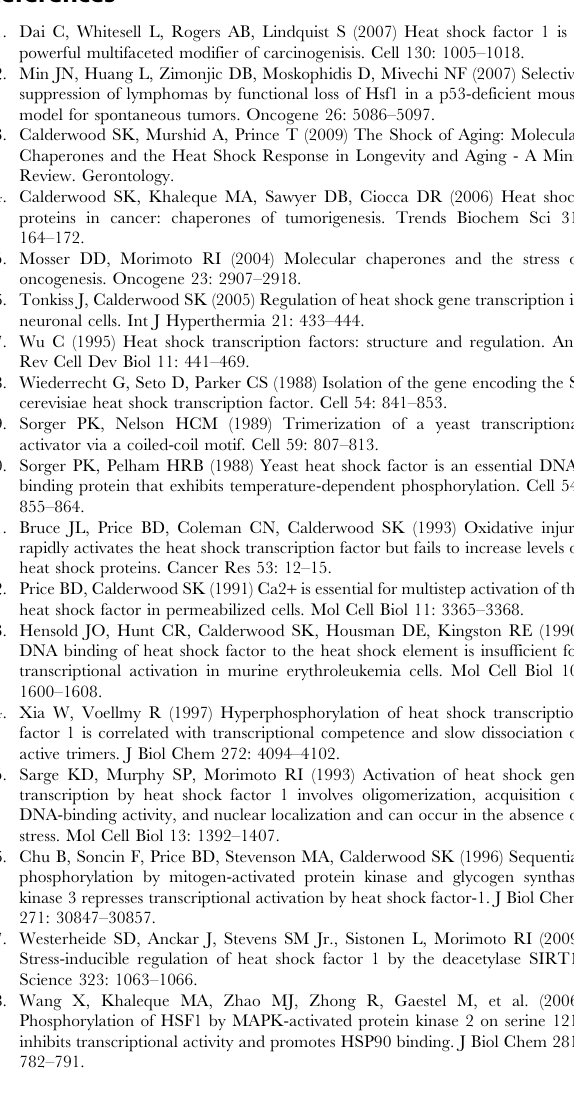
Figure S3 Quantitative analysis of the distribution of HSF1 in wt HeLa, HeLa (PKA scr) and HeLa (PKA kd # 1) cells under non- treated, heat shock or LMB treated conditions as indicated in figure was performed after confocal fluorescence microscopy. The sub-cellular distribution of HSF1 was scored according to whether the protein was detected in the nucleus, in both nucleus and cytoplasm or strictly in the cytoplasm. Figure S4 PKAc a associates with pS320 HSF1 in